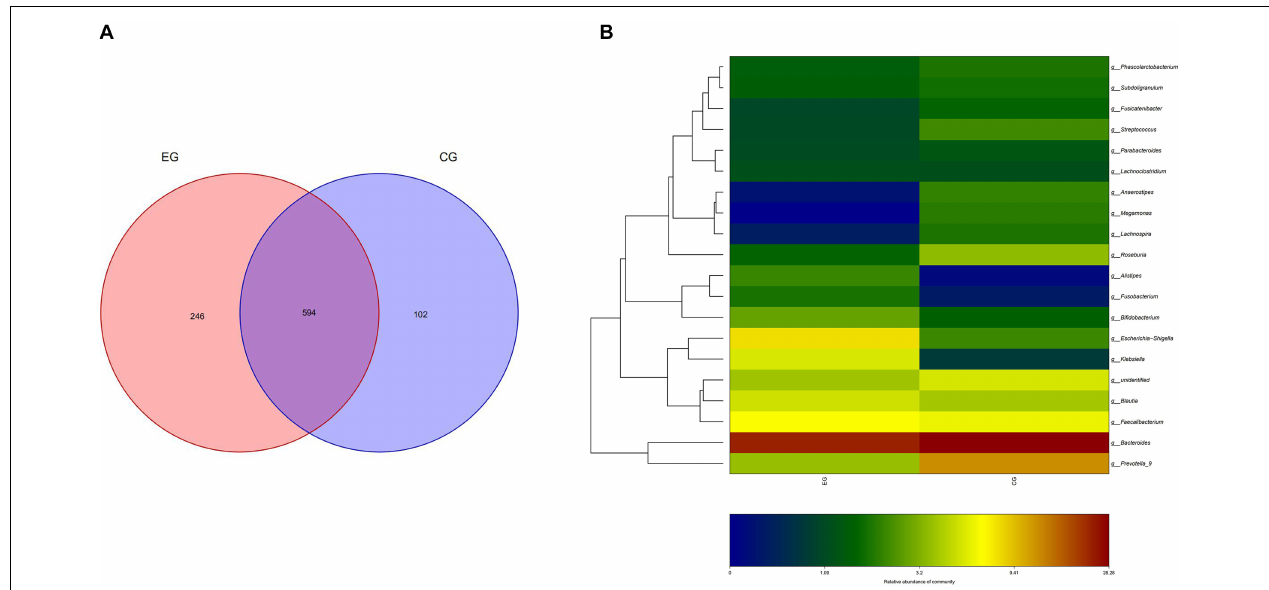
FIGURE 1 | OTU distribution and OTU notes of EG and CG. (A) Number of OTUs shared by both groups and unique to each group is represented by Venn diagram. (B) Cluster analysis of species/OTU relationship at genus level. The horizontal ordinate is the name of the two groups, and the longitudinal ordinate is the name of species/OTU at genus level. The depth of color represents the level of